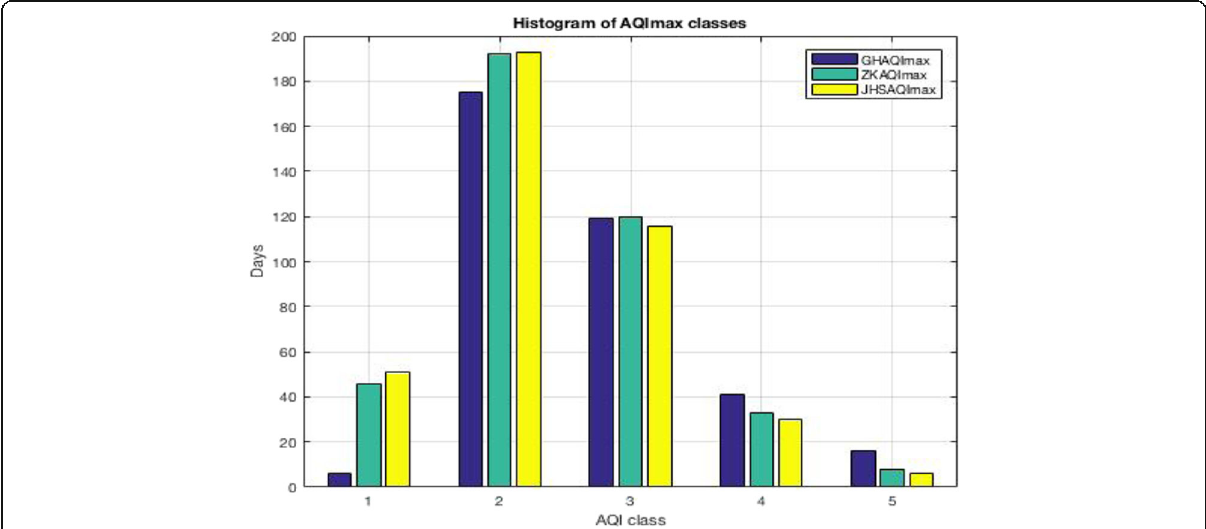
Fig. 2 Histogram of AQI classes. It computes the cumulative days of various different air quality classes at different localities in the observation period. The first group of histograms shows the days that belong to the first AQI class at three locations. The second group of histograms shows the days that belong to the second AQI class at three locations. The third group of histograms shows the days that belong to the third AQI class at three locations. The fourth group of histograms shows the days that belong to the fourth AQI class at three locations. The fifth group of histograms shows the days that belong to the fifth AQI class at three locations. The blue column is the result of the GH locality and the green column is the result of the ZKX locality. The yellow column is the result of the JHS locality